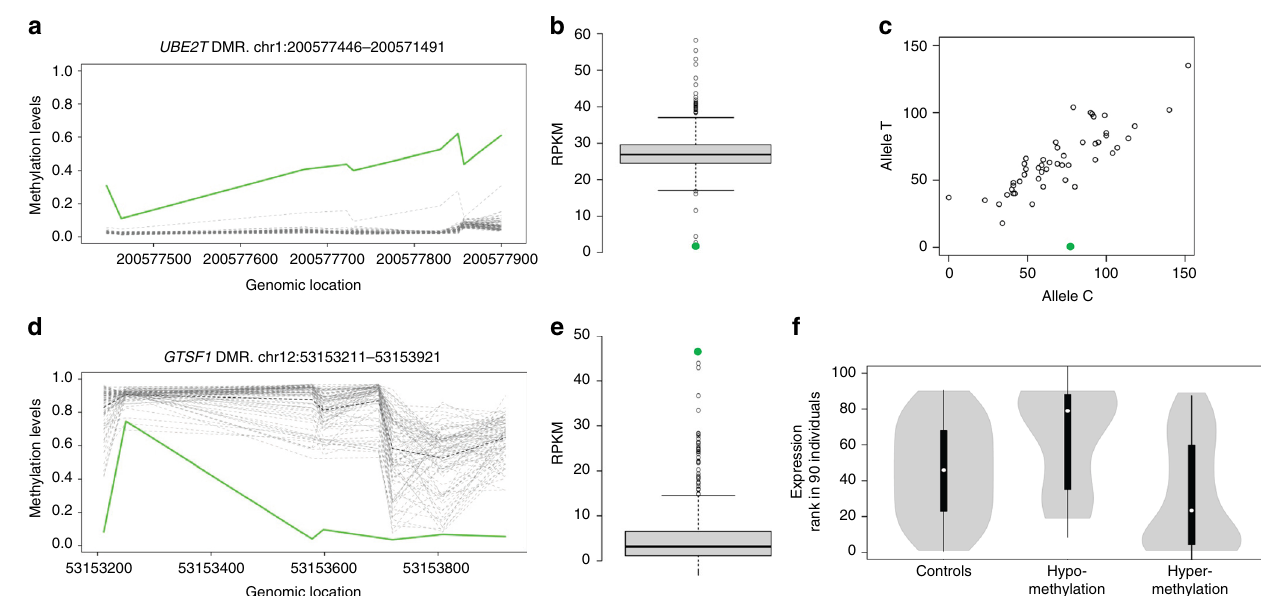
Fig. 5 Epivariations are frequently associated with large changes in gene expression. We identi fi ed epivariations in 90 lymphoblastoid cell lines studied as part of the 1000 Genomes Project, and combined these with SNP genotypes and RNAseq data from a total of 462 samples to measure quantitative and allelic effects of epivariations on gene expression. a An individual with hypermethylation of the UBE2T promoter (solid green line) compared to 89 other individuals (dashed gray lines) presented b the lowest gene expression (green dot on the boxplot) of the cohort. c Using heterozygous SNPs within RNAseq reads, we observed monoallelic expression of UBE2T in the epivariation carrier (outlier highlighted in green). d An individual with hypomethylation of the GTSF1 promoter (solid green line) presents e the highest level of expression (green dot on the boxplot). f Violin plots show that individuals with hypomethylated epivariations at gene promoters show signi fi cantly increased expression of that gene, whereas individuals with hypermethylated promoter epivariations show signi fi cantly reduced expression of that gene ( p = 9.2 × 10 − 5 , Wilcoxon Rank-Sum test). In box plots ( b and e ), the center line shows the median; box limits indicate the 25th and 75th percentiles; whiskers extend 1.5 times the interquartile range from the 25th and 75th percentiles; outliers are shown as individual points. In the violin plot ( f ), the white dots show the median; box limits indicate the 25th and 75th percentiles; whiskers extend 1.5 times the interquartile range from the 25th and 75th percentiles